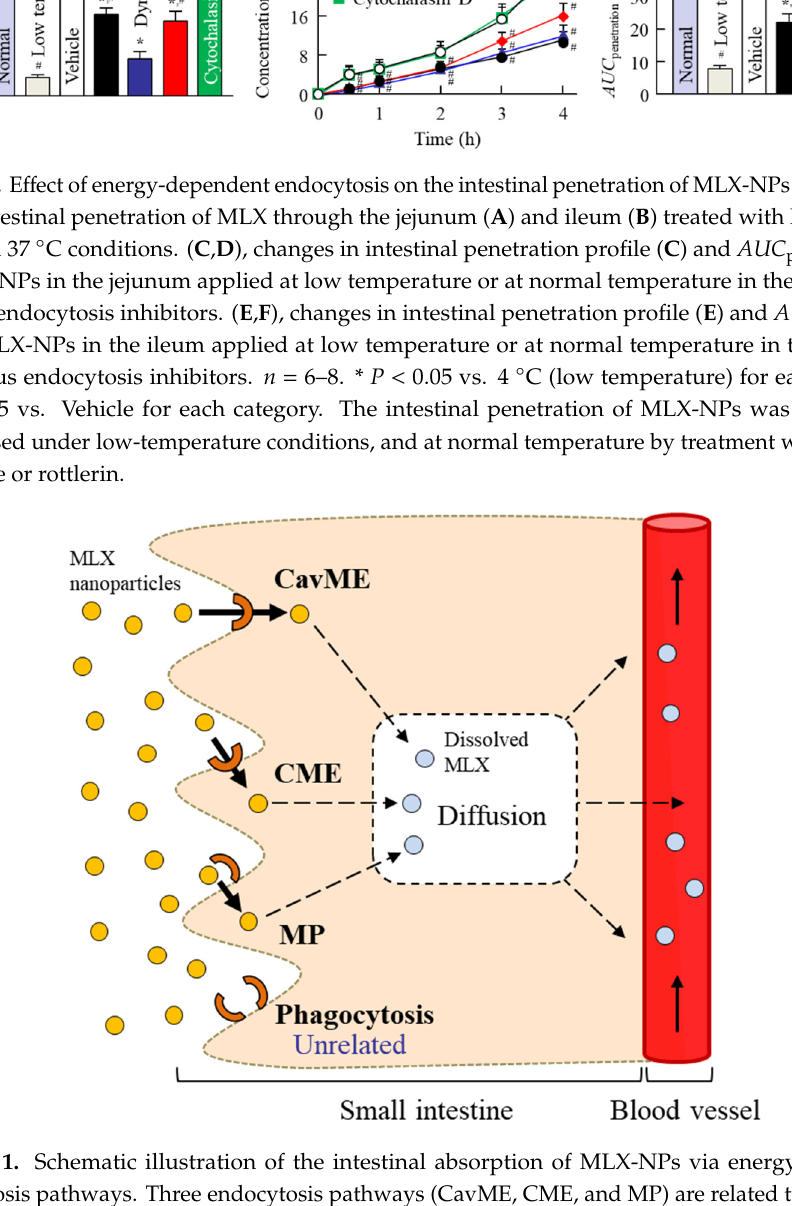
Scheme 1. Schematic illustration of the intestinal absorption of MLX-NPs via energy-dependent endocytosis pathways. Three endocytosis pathways (CavME, CME, and MP) are related to the uptake of MLX nanoparticles. The absorbed MLX nanoparticles are dissolved in the small intestine and